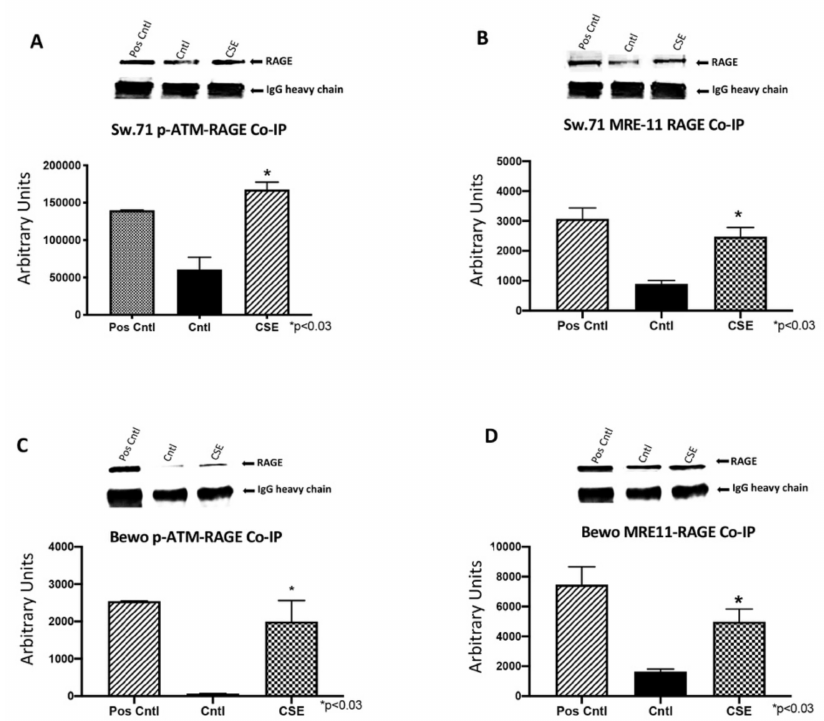
Figure 8. RAGE interacts with ATM and MRE11 during CSE and BLM induced DNA-DSBs. In- creased pATM-RAGE ( A ) or MRE11-RAGE ( B ) complexes in CSE treated Sw.71 when compared to controls. Increased pATM-RAGE ( C ) or MRE11-RAGE ( D ) complexes in CSE treated Bewo cells when compared to controls.